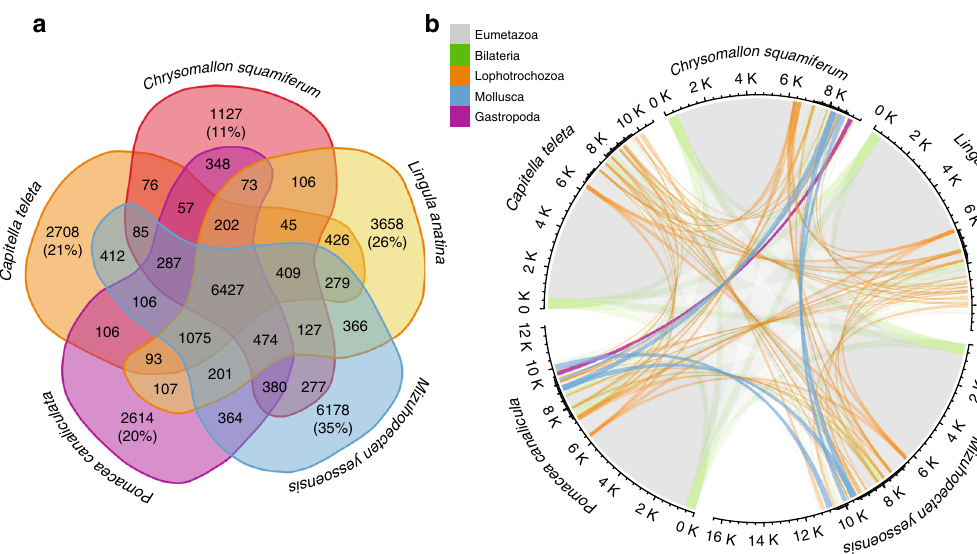
Fig. 3 Gene family analyses of lophotrochozoan genomes. a Venn diagram showing the number of shared and unique gene families among fi ve lophotrochozoan genomes. b Circos plot showing the proportion and origin of shared gene families across fi ve lophotrochozoan taxa. Arc values correspond to the number of gene families. Genes shared across Eumetazoa are indicated by grey lines, Bilateria by green lines, Lophotrochozoa by orange lines, Mollusca by blue lines, and Gastropoda by purple lines. K, kilo (1000). Source data are provided as a Source Data fi le.